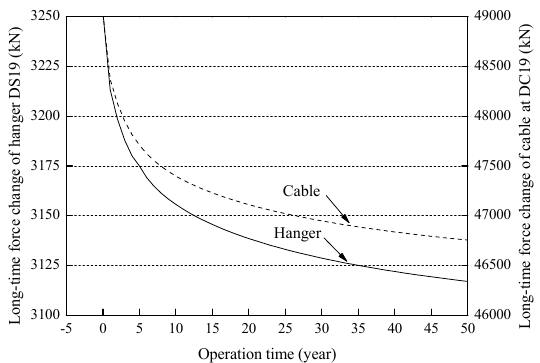
Figure 16. Predicted changes of hanger and cable forces at DS19.